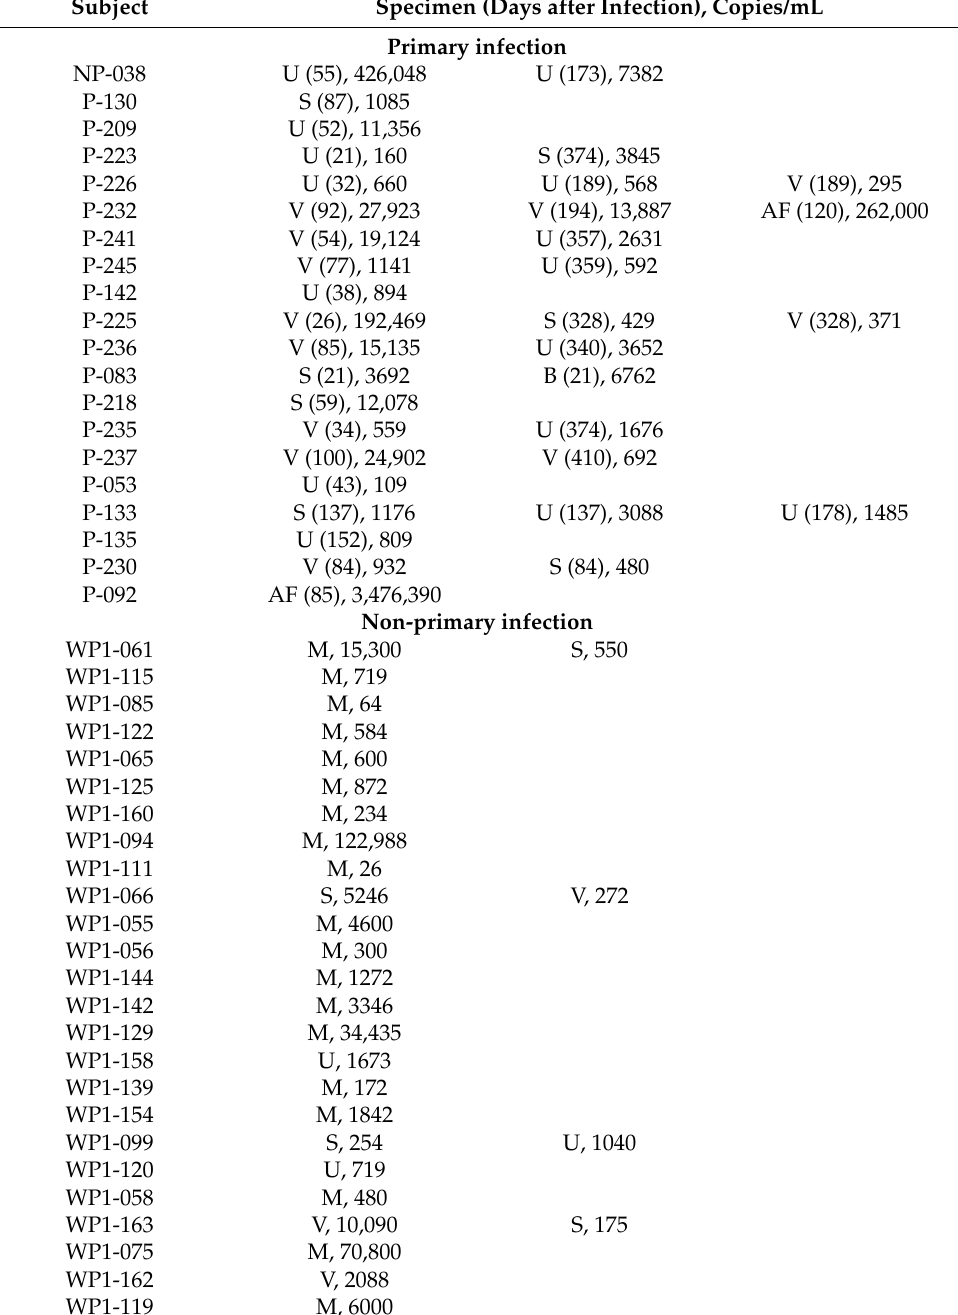
Table 2. Quantitative levels of HCMV-DNA detected in the clinical samples of 20 subjects with primary infection and 25 women with non-primary